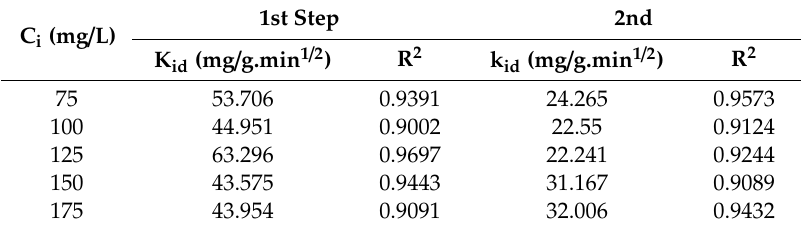
Figure 14. Intra-particle diffusion plot for adsorption of Pb(II) ions onto PAN/SL ACNFs at different initial Pb(II) concentrations; ( a ) 75, ( b ) 100, ( c ) 125, ( d ) 150 and ( e ) 175 mg / L. Condition: contact time = 240 min, dosage of adsorbent = 40 mg, pH = 5. Table 3. Intra-particle diffusion constant for adsorption of Pb(II) ions onto PAN/SL ACNFs at different initial Pb(II) concentrations. Condition: contact time = 240 mins, dosage of adsorbent = 40 mg, and pH = 5.